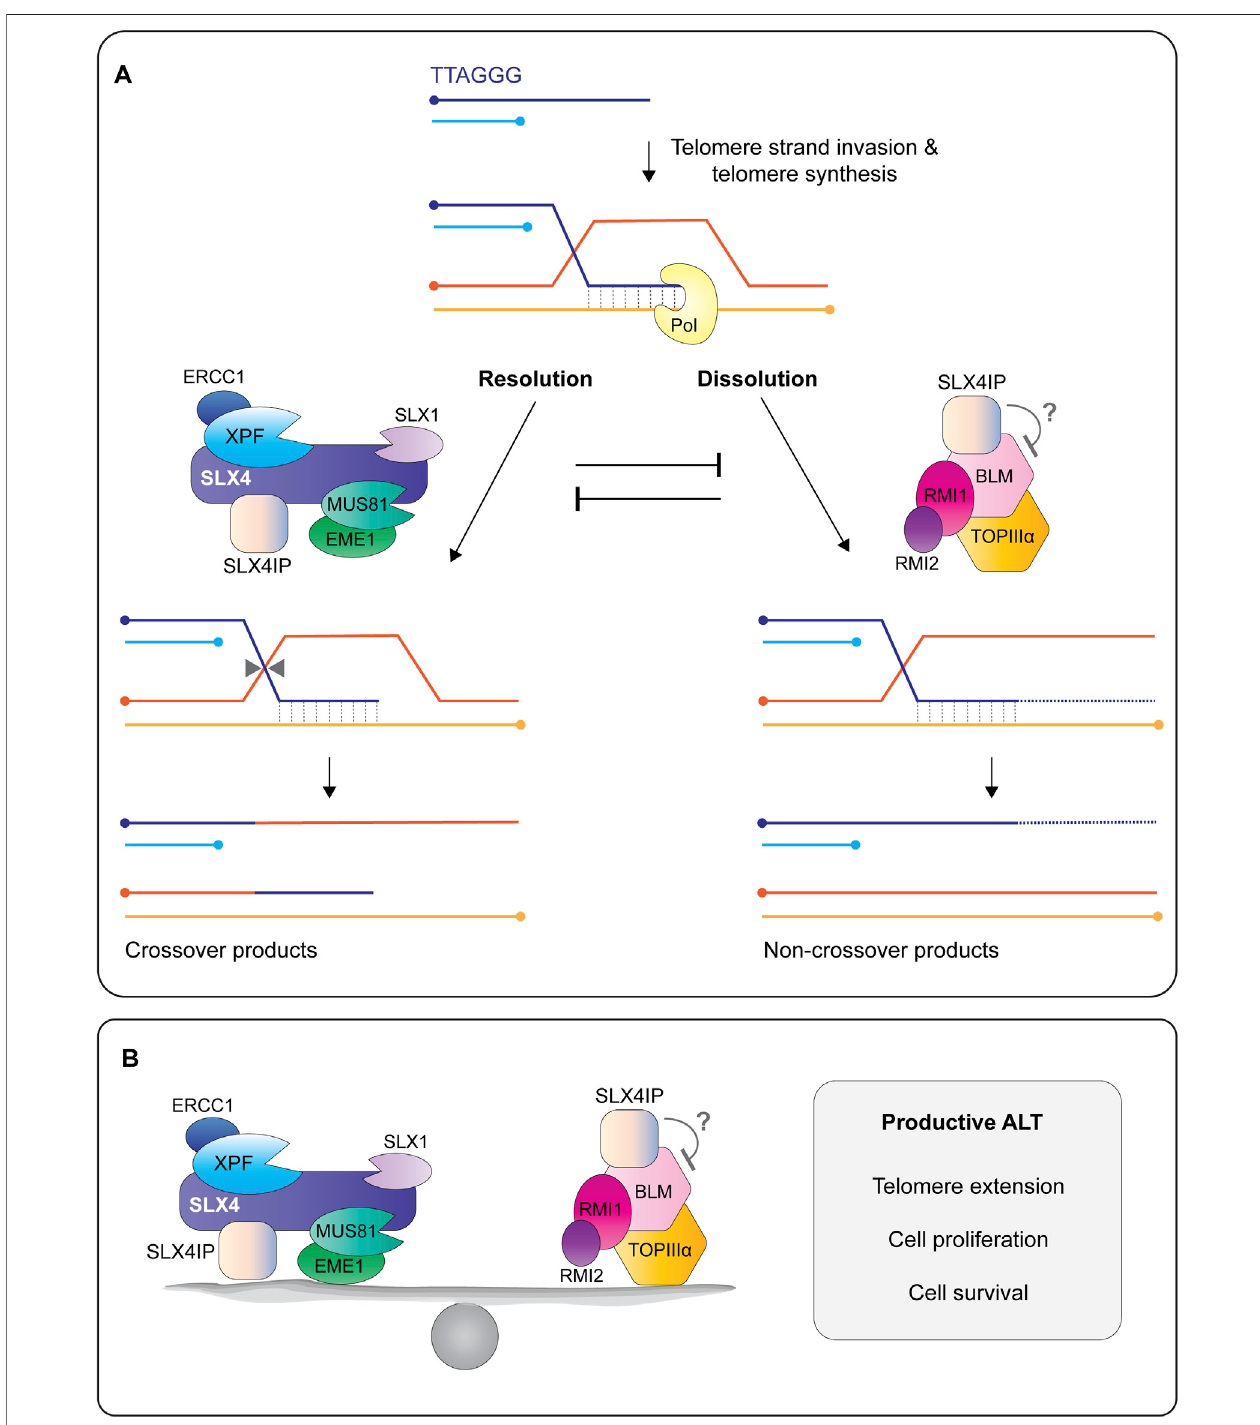
FIGURE9| SLX4IPisacriticalregulatorofthealternativelengtheningoftelomeres(ALT)pathway. (A) The3 ′ G-richtailundergoesintertelomericstrandinvasion,generatinga branchedDNAstructurecalledadisplacement-loop(D-loop).Strandinvasionpromotesbreak-inducedtelomeresynthesisusingoneofseveraldifferentpolymerases,shownhere asPol.Telomereextensionisregulatedbytheopposingactionsofstructure-selectiveendonucleasesandahelicase-topoisomerasecomplex.Intheresolutionpathway (left) ,the D-loop is cleaved/resolved by the endonucleases bound to SLX4, resulting a telomere exchange event (crossover) in the absence of telomere extension. In the dissolution pathway (right) , a protein complex containing the BLM helicase, TOPIII α topoisomerase, and RMI1/2 proteins promotes branch migration and long tract telomere synthesis, followedbyD-loopdissolutionintonon-crossoverproducts.RecentworkshowsthatSLX4IPfunctionsinbothpathwaysthroughitsinteractionswithSLX4,XPFandBLM.Circles indicate5 ′ -termini. (B) CurrentmodeldepictingSLX4IPasaproteinthatbalancesthetwomolecularpathwaysthatregulatetelomerelengthinALTcells:resolutionofrecombining telomeres by SLX4 and its associated endonucleases and dissolution of recombining telomeres by the BTR complex. The presence of SLX4IP is essential for telomere length maintenance in ALT cells, as well as cell proliferation and survival. More work is needed to determine the mechanism(s) by which SLX4IP achieves this balance.